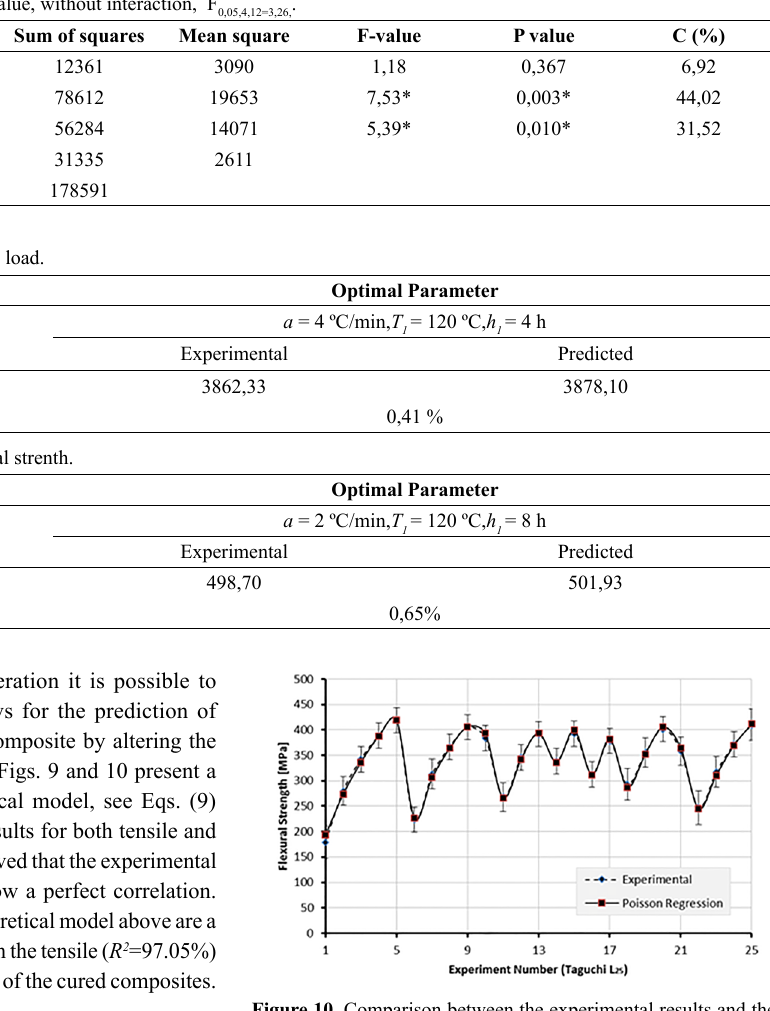
Table 6. ANOVA for Flexural stress value, without interaction, F